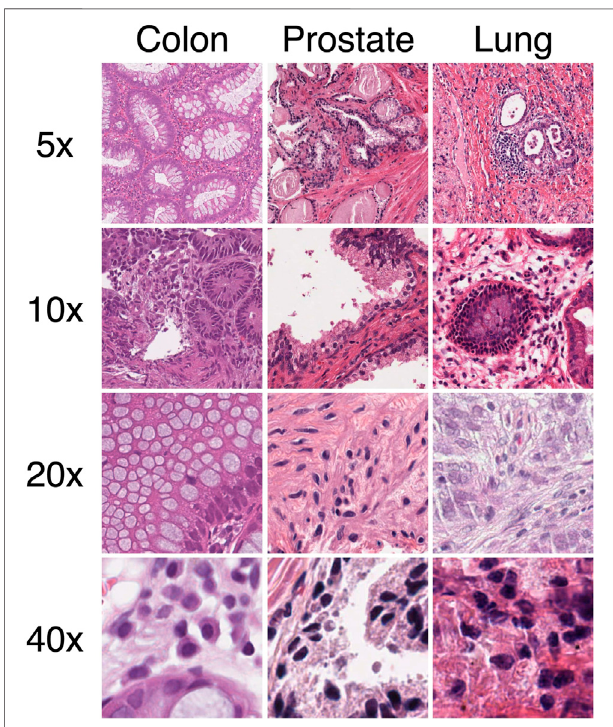
FIGURE 2 | An example of tissue represented at multiple magni fi cation level (5x, 10x, 20x, 40x). The tissues come from colon, prostate and lung cancer